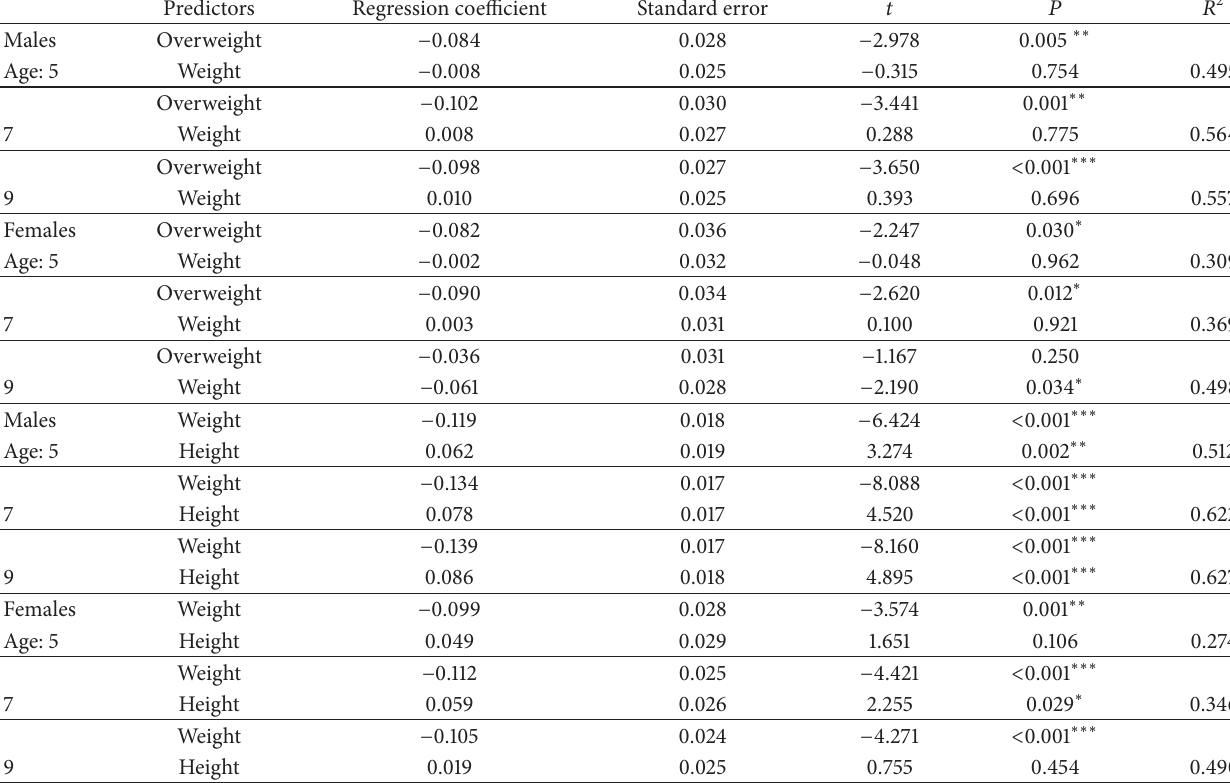
Table 5: Regression coefficients (standard errors) of predictors of age at PHV.